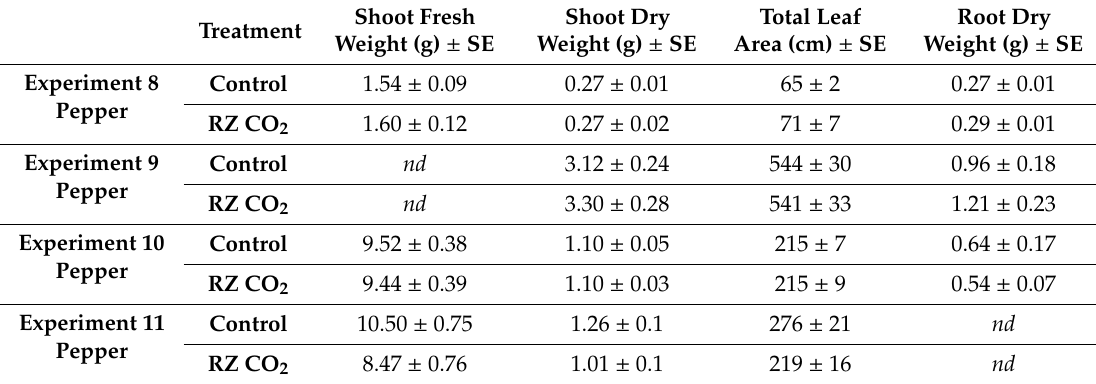
Table 6. Shoot fresh weight, shoot dry weight and root dry weight mean values of pepper plants grown aeroponically. Experiment 8–11. Data are means ± SE of 8 replicates. Asterisks indicate significant di ff erences between treatments (* p < 0.05; ** p <